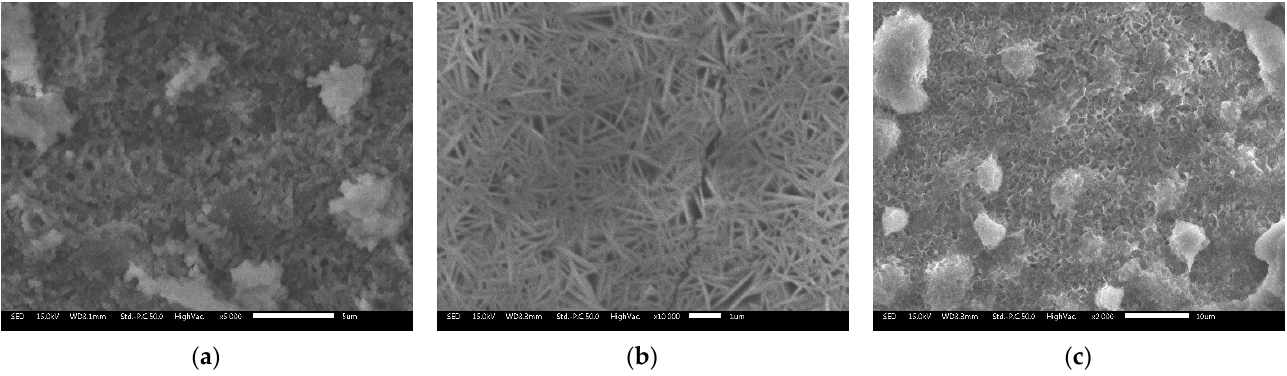
Figure 8. SEM images of the top-view of the investigated samples after 400 h of immersion in 0.1 M NaCl: ( a ) C10-1, ( b ) C10-4.5, and ( c ) C10-9.